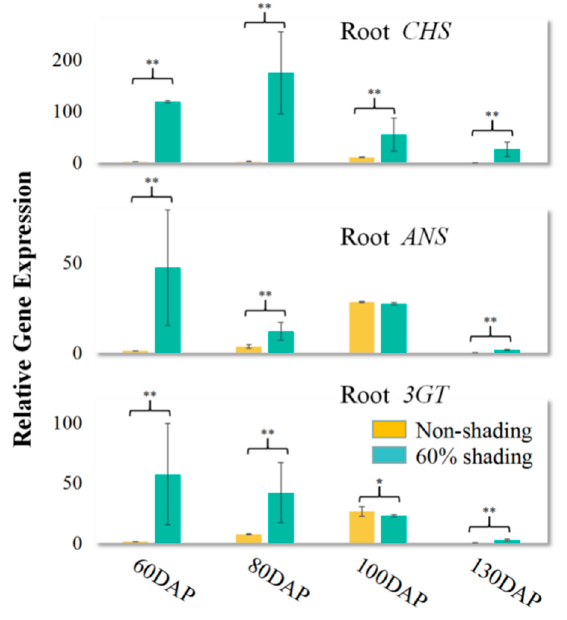
Figure 8. Gene expression analysis of three key enzymes in the storage root flavonoid pathway from PSP. Data represent the mean ± SD of three individual plants (n = 3) with root-mixed samples per plant. The asterisks represent significant differences ( * , p < 0.05; **, p < 0.01). chalcone synthase, CHS; anthocyanidin synthase, ANS; UDP glucose flavonoid 3-O-glycosyltransferase, 3GT; purple-fleshed sweet potato, PSP.